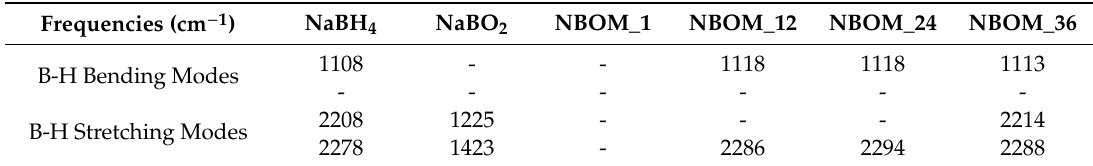
Figure 3. XRD patterns of materials ( A ): (a) Mg–Al-based alloy; (b) NaBO 2 ; (c) NaBH 4 ; (d) NBOM_1; (e) NBOM_12; (f) NBOM_24, and (g) NBOM_36; ( B ): (a) Mg-based alloy; (b) LiBO 2 ; (c) LiBH 4 ; (d) LBOM_1; (e) LBOM_12; (f) LBOM_24, and (g) LBOM_36. Table 3. Infrared vibration bands of NaBH 4 , NaBO 2 , and ball-milled materials at di ff erent milling time durations at room temperature.